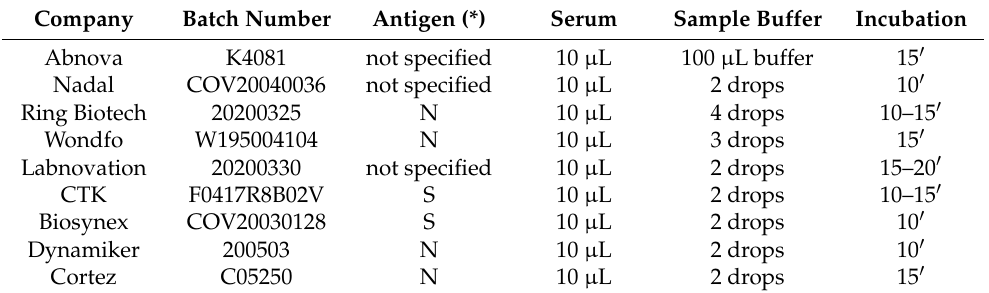
Table 2. Lateral flow assays with manufacturer’s specifications: the manufacturer, batch number, serum volume, sample buffer, and incubation time are listed. Target antigens are listed when available.